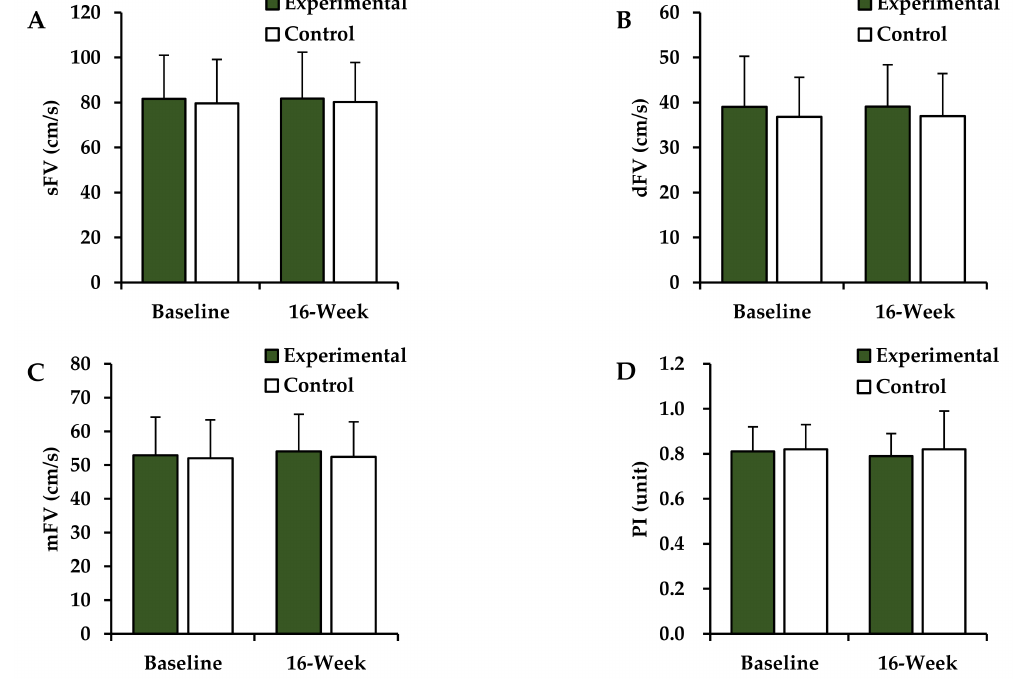
Figure 1. Changes in CBF velocities. Values are presented as mean ± SD. ( A ) sFV, systolic flow velocity; ( B ) dFV, diastolic flow velocity; ( C ) mFV, mean flow velocity; ( D ) PI, pulsatility